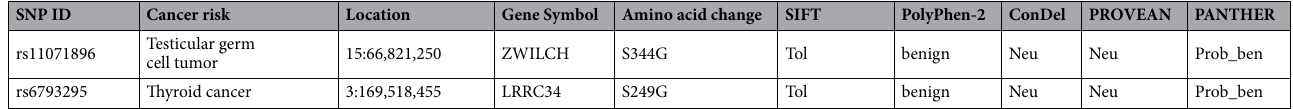
Table 3. List of 52 nsSNPs identified among the Orang Asli and the Malays and functional effect predicted by five in silico programs. Del = Deleterious, Tol = Tolerated, Pro_dam = Probably damaging, Pos_dam = Possibly damaging, Prob_ben = Probably benign, Neutral = Neu,—= Not predicted. *nsSNPs which are found in Orang Asli only. **nsSNPs which are commonly found in Malays only. The highlighted rows were the selected nsSNPs for further investigation.